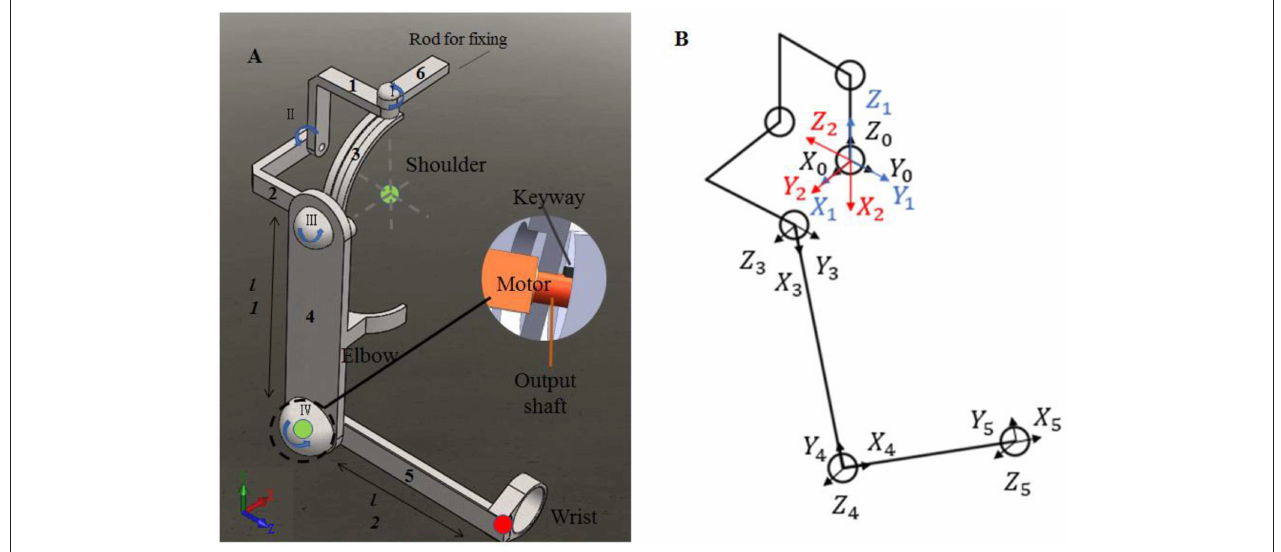
FIGURE 4 | The assistive exoskeleton model and its coordinate system. (A) Assistive exoskeleton model for right upper limb assistive exoskeleton model; (B) the coordinate system of assistive exoskeleton for Denavit-Hartenberg (D-H) model. The red circle dot in left panel was the endpoint position in D-H model during reaching movement (the end point of bracket 5).